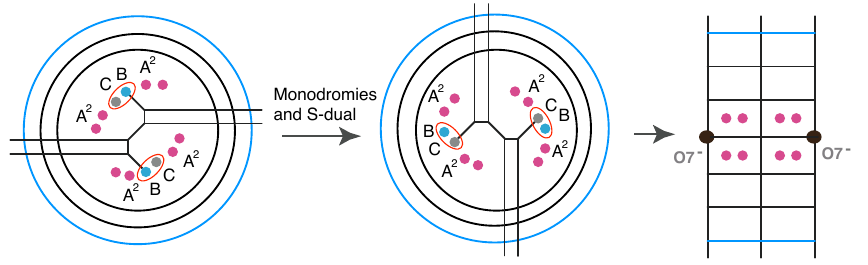
Figure 45 . A T-dual version of 6d [1 A ; 8] (cid:0) SU(4) (cid:0) SU(4) (cid:0) SU(4) (cid:0) [4] yielding 5d [1 A ; 4] (cid:0) SU(7) SU(7) [1 A ; 4] implementing S-dual invariant 7-brane combinations. (cid:0) (cid:0)